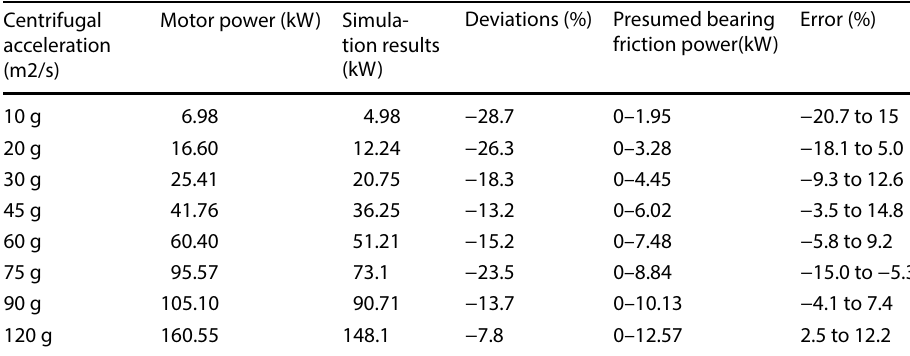
Motor power (kW) Simula-